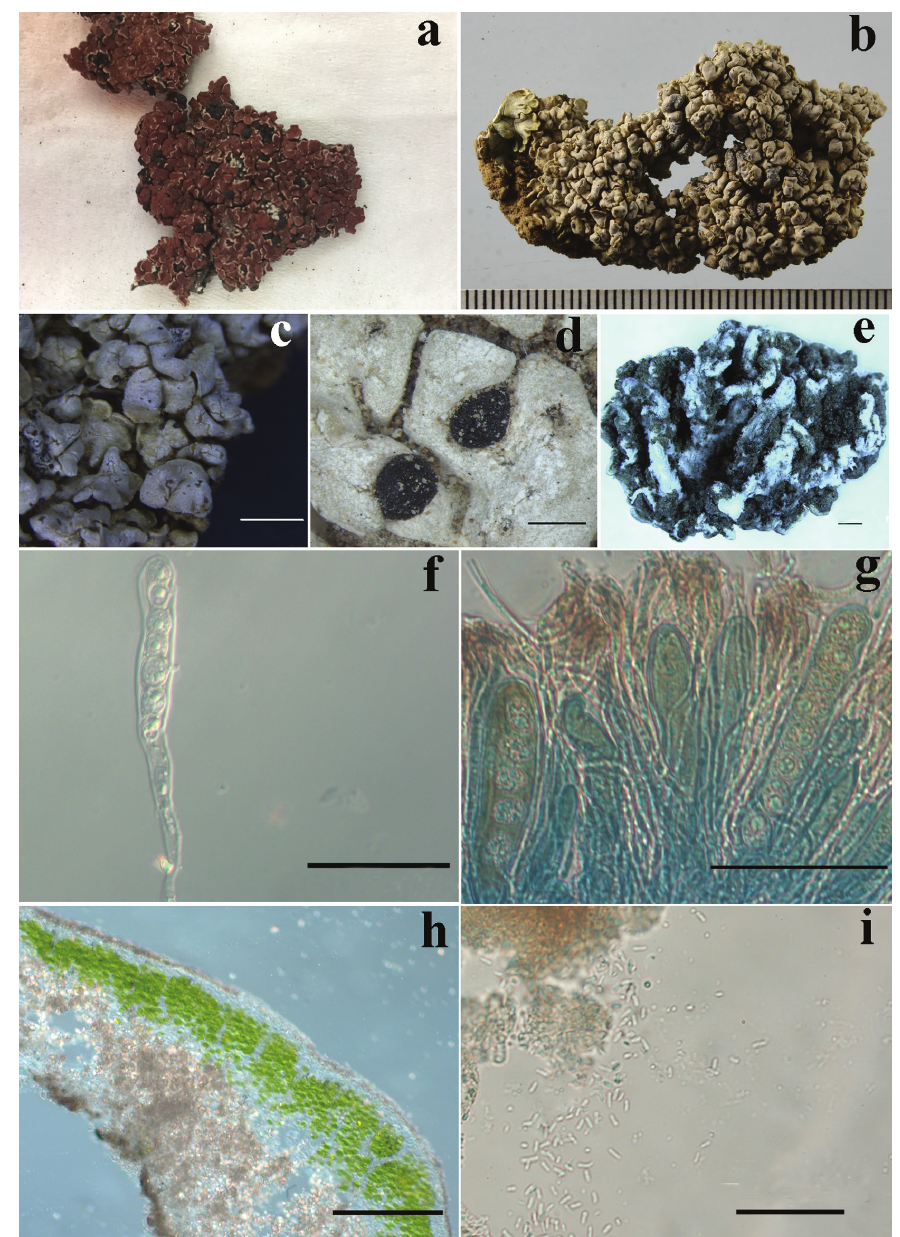
Figure 2. The new species Anamylopsora pruinosa (holotype, HMAS–L–141383). a Lichen thallus habit of Anamylopsora pulcherrima (C0090112F, F) b Lichen thallus habit of Anamylopsora pruinosa (holotype, HMAS–L–141383), scale in mm c Pruinose upper surface of the new species d The marginal apothecia of the new species e The abundant and thick and strong rhizines (white) at the lower surface f The asci with ascospores of the new species g The asci in iodine, showing the amyloid sheet h The thallus anatomical structure of the new species i The shortly bacilliform conidia of the new species. Scale bars: 0.2 mm ( c ); 0.5 mm ( d ); 0.95 mm ( e ); 50 µm ( f, g ); 200 µm ( h ); 50 µm ( i